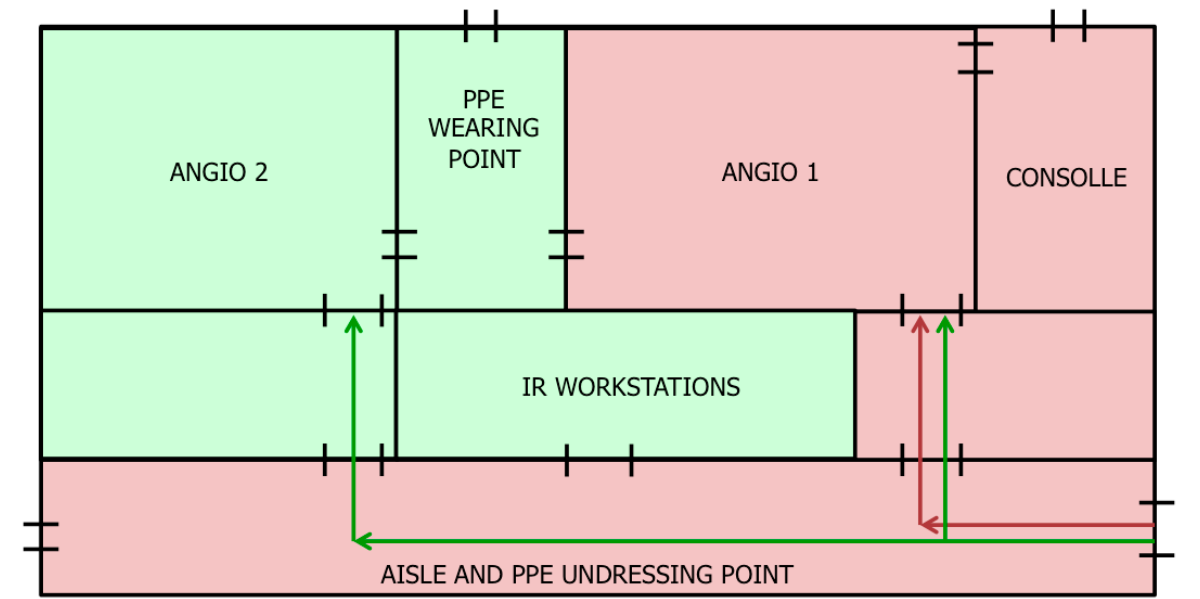
Figure 2. Plan of our IR unit. “ANGIO 1” is the angio-suite with a flat panel digital detector angiograph, while “ANGIO 2” is furnished with a C-arm fluoroscope. The red arrows represent the “COVID-19 route”, while the green arrows represent the route of non-COVID-19 patients. Due to the architectural characteristic of our department, it wasn’t possible to create a specific route for COVID-19 patients totally separated from the clean one. When a confirmed or suspected COVID-19 patients undergo IR procedures, the red areas can be separeted from the green ones, mantaining them clean. The red areas undergo specific cleaning protocol after each COVID-19 procedure.